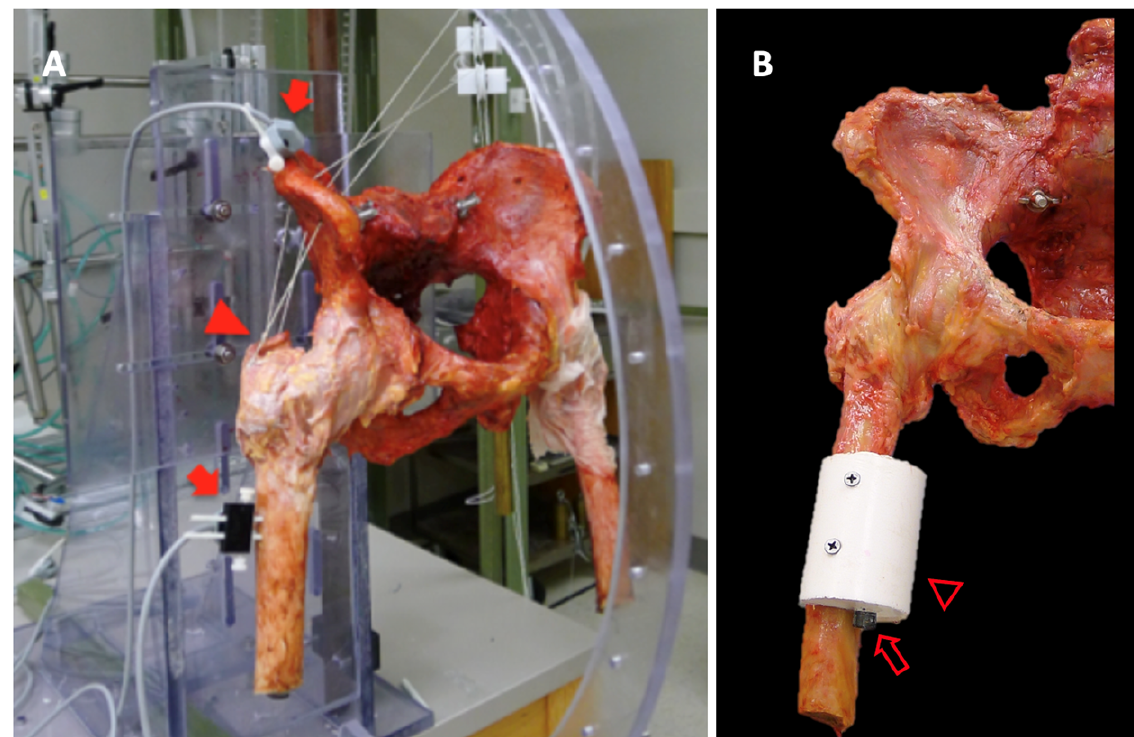
Figure 1. ( A ). Entire pelvic specimen was used for the test with electromagnetic sensors attached to the iliac spine and femur (arrow). The sutures loaded with 18 N weight were attached to the abductor tendons (arrowhead) to maintain a compressive force to keep the femoral head in contact with the acetabulum. ( B ). Adopter (hollow arrowhead) with a screw head (hollow arrow) was attached to the femur. Using the screw head, torque could be applied along the mechanical axis of the